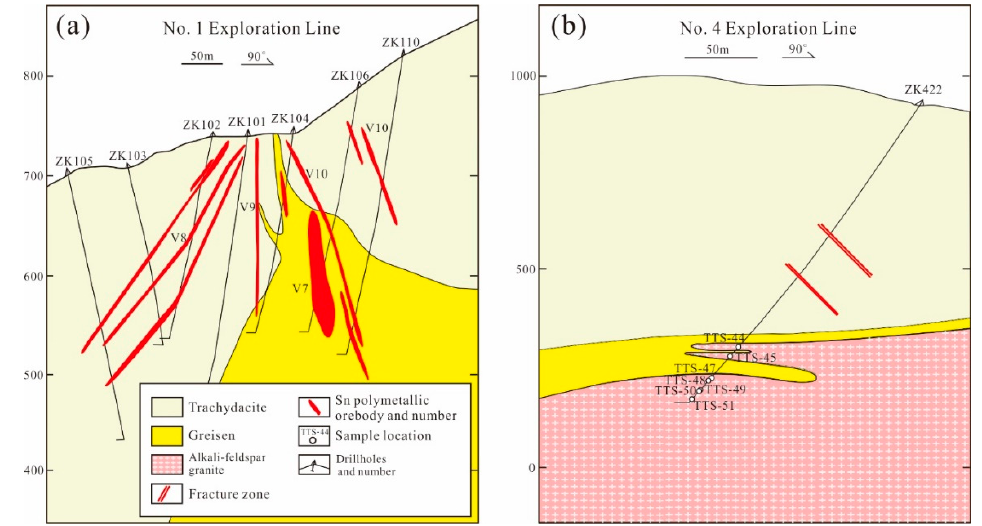
Figure 3. Geological cross-section along the exploration line No.1 ( a ) and No.4 ( b ).